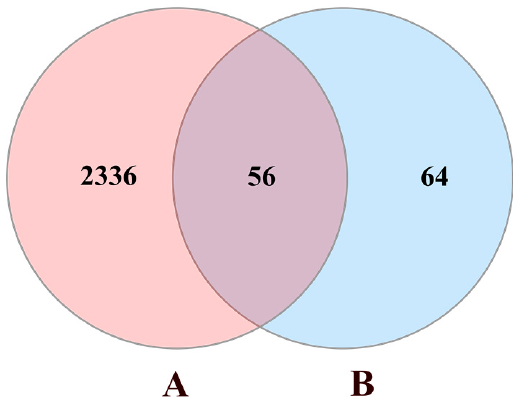
Figure 2. Venn diagram of naringenin-treated Chronic obstructive pulmonary disease (COPD) targets. Circle A represents 2392 COPD-related targets. Circle B represents 120 targets of naringenin. The intersection of two circles represents 56 common targets.